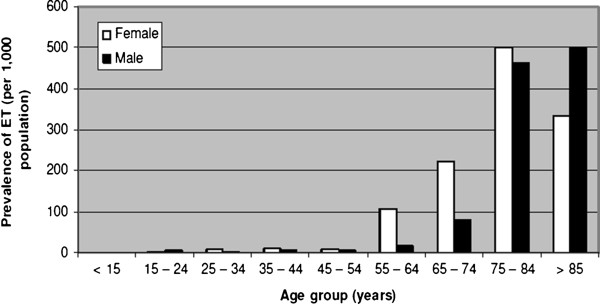
 Prevalence of essential tremorper 1,000 population byage strata and gender.